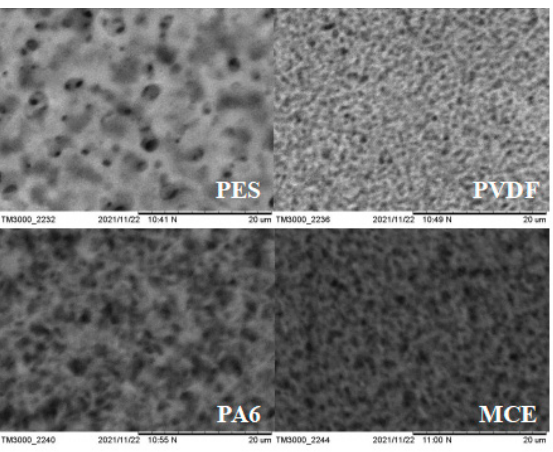
Figure 6. SEM images of the surface of pristine PES, PVDF, PA6 and MCE membranes.